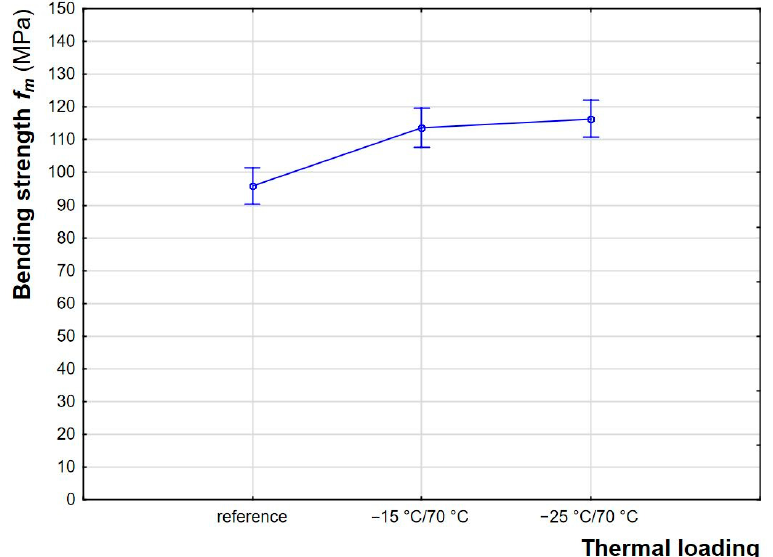
Figure 4. The effect of thermal loading on the bending strength.